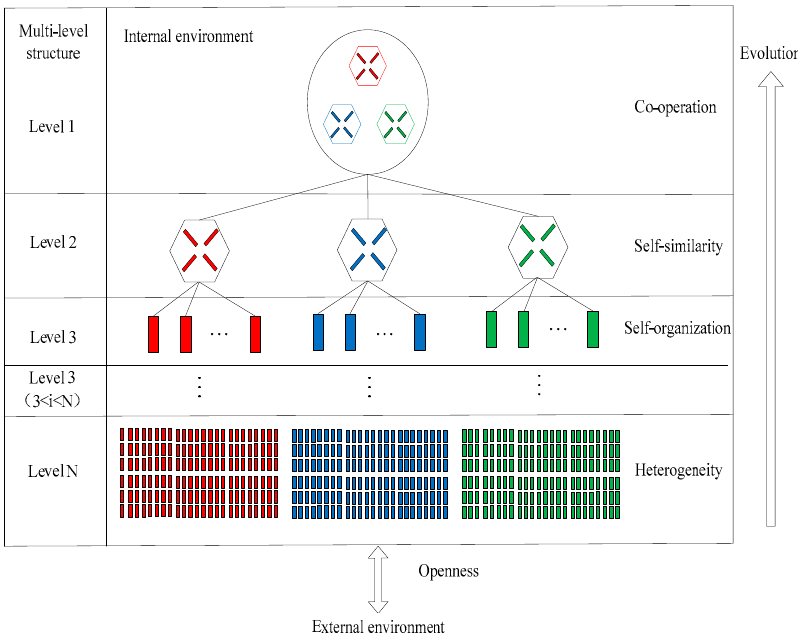
Figure 7. Qualitative analysis of the MC–SIOT system.